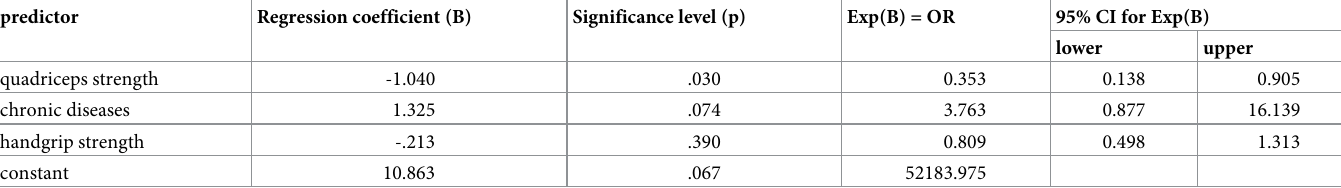
Table 3. Binary logistic regression with inclusion analysis of the variables quadriceps strength, chronic diseases and physical activity. predictor Regression coefficient (B)